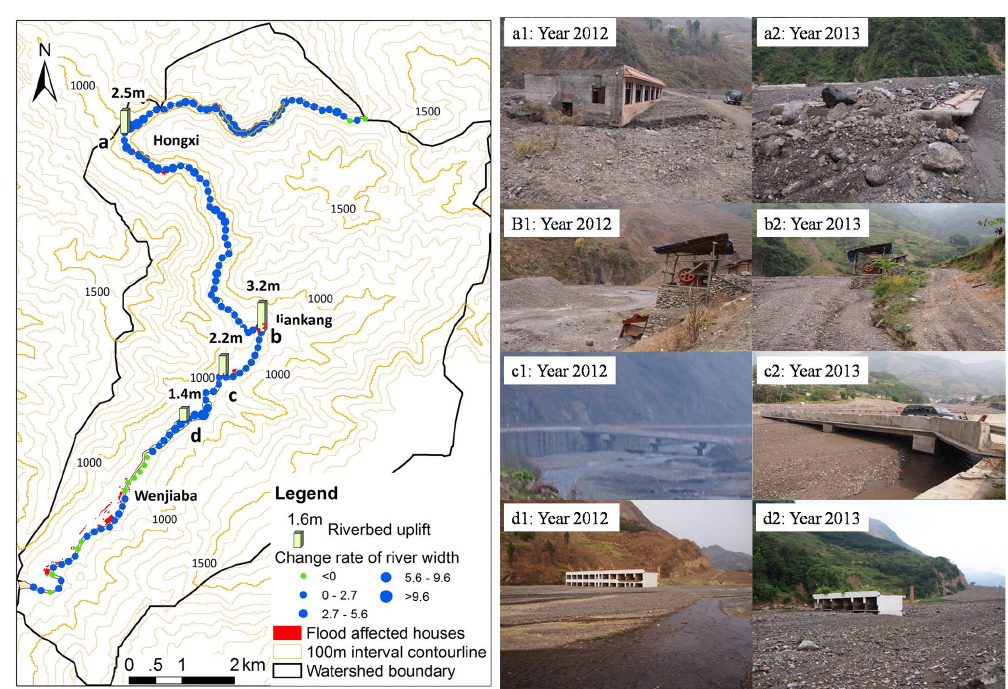
Figure 2. Accumulation of debris on the riverbed at four locations and distribution of flooded houses during the 2013 August flood (photos of a1, b1, c1, and d1 were taken in August 2012; a2, b2, c2, and d2 were taken in September